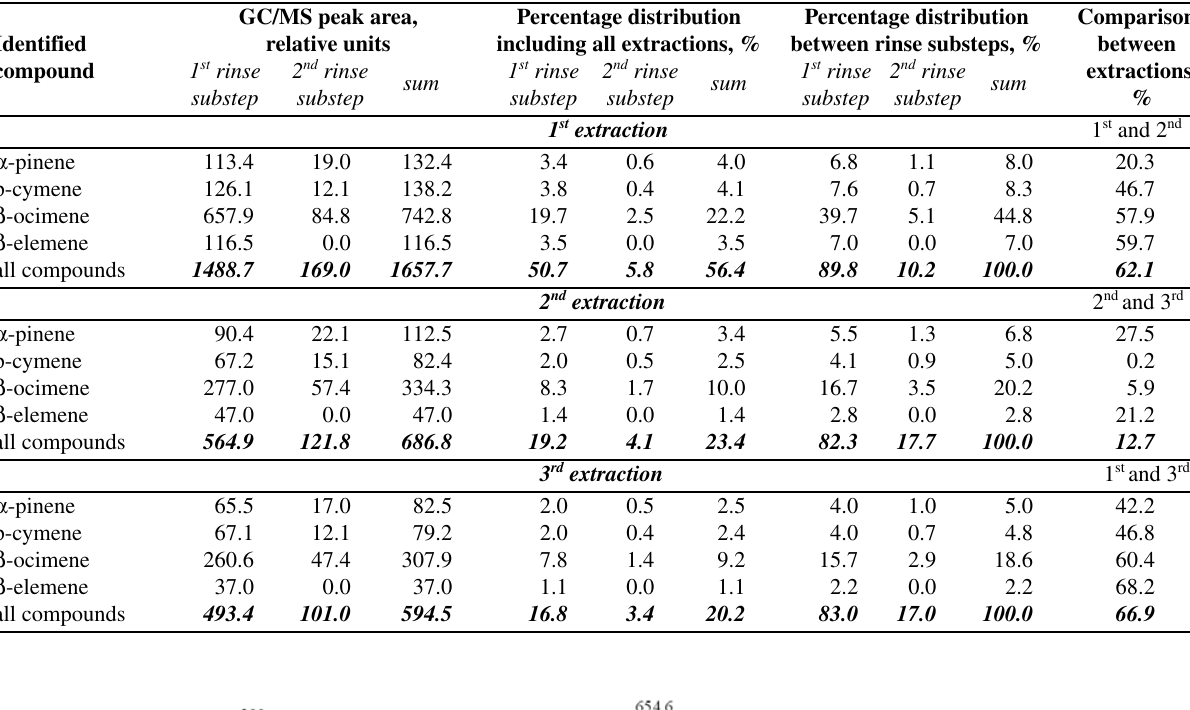
Table 1 . Distribution of the main compounds in the essential oils of Bidens tripartita L. after three extractions of the same sample using two rinse substeps GC/MS peak area, Percentage distribution Percentage distribution Comparison